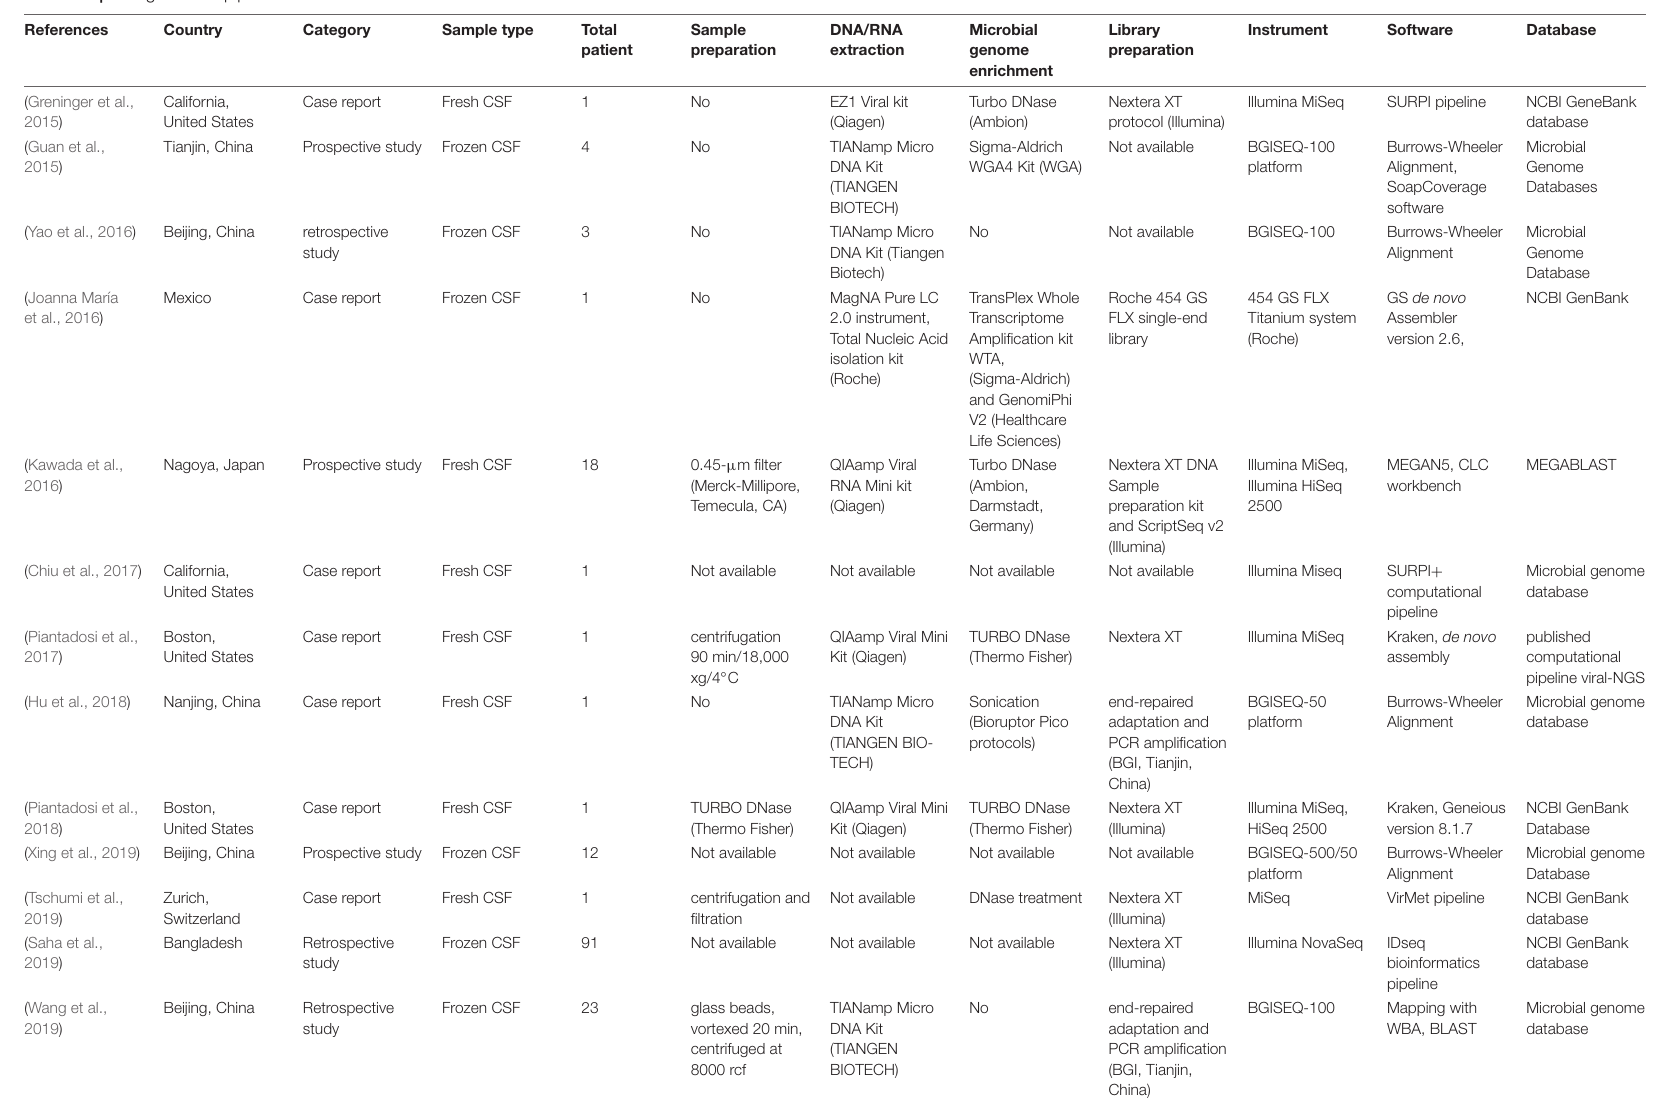
TABLE 1 | Metagenomics pipelines.